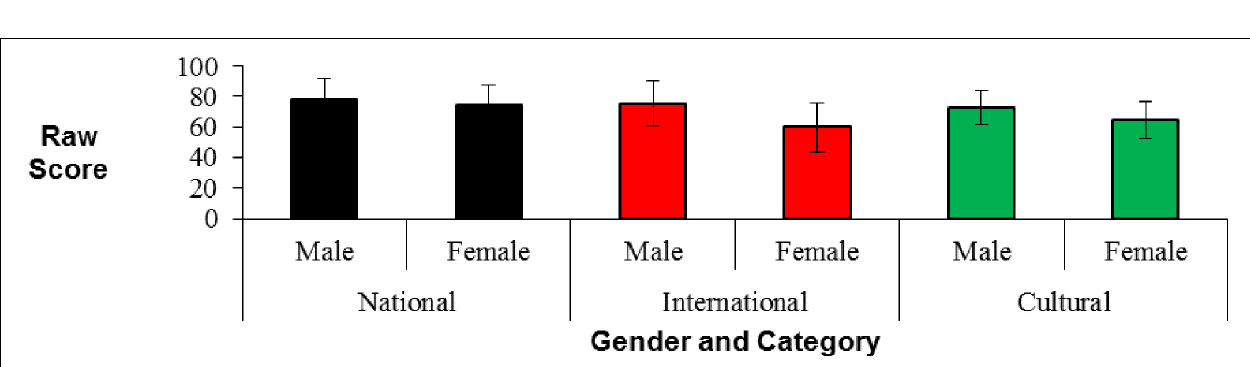
FIGURE 3 | Scores [mean ( sd )] on the Public Events Questionnaire by gender for